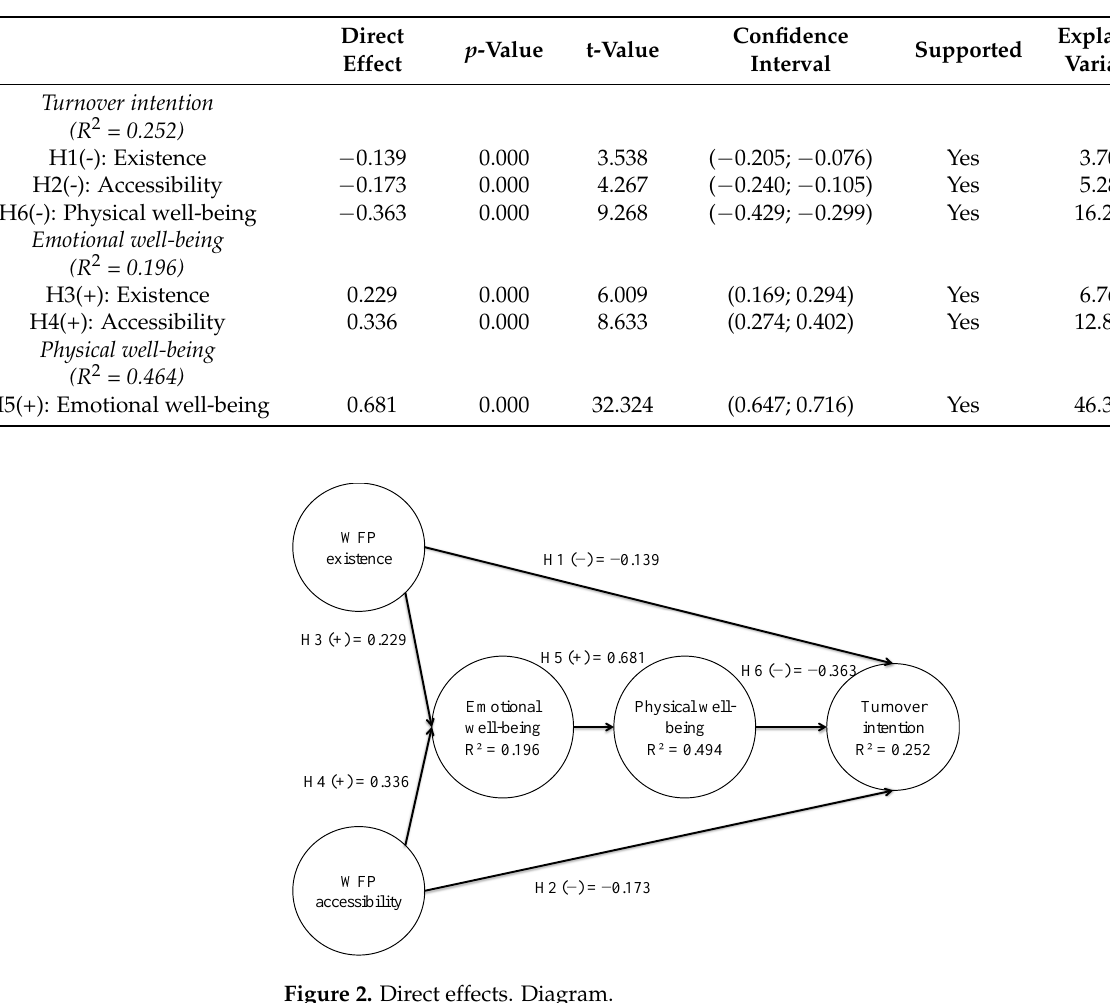
Table 3. Direct effects. Hypotheses.